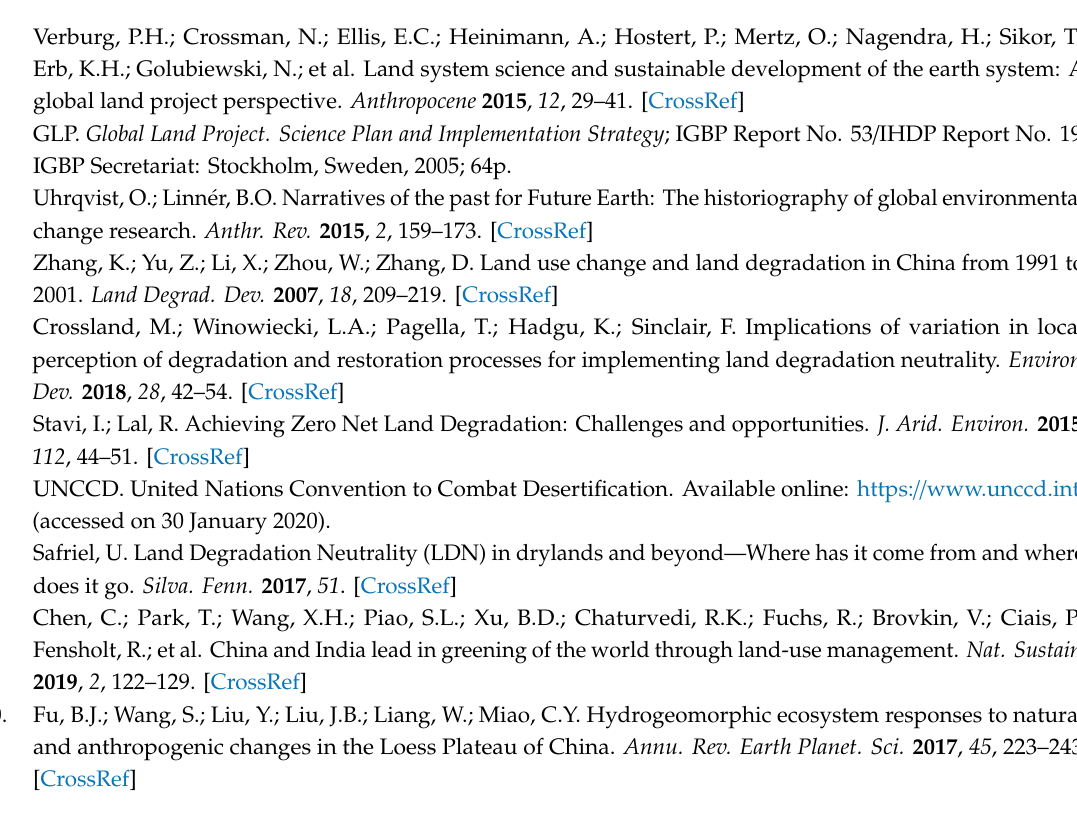
Figure S1. Major ecological restoration programs under implementation in China. Figure S2. Estimation of GW Logistic Regression coe ffi cients for the remaining explanatory factors. Figure S3. Estimation of GWR coe ffi cients for the remaining explanatory factors. Table S1. Selection of topographic, climatic and accessible variables for the forestland, grassland, cropland and built-up land models. Table S2. Selection of socioeconomic factors for the period 1990–2000. Table S3. Selection of socioeconomic factors for the period 2000–2015. Table S4. Transition of area from 1990 to 2000 (a), 2000–2015 (b) and 1990–2015 (c) (km 2 ). Table S5. Explanatory factors and the summary statistics of their varying (local) coe ffi cients in the GWLR models. Table S6. Explanatory factors and the summary statistics of their varying (local) coe ffi cients in the GWR models (1990–2000), Table S7. Explanatory factors and